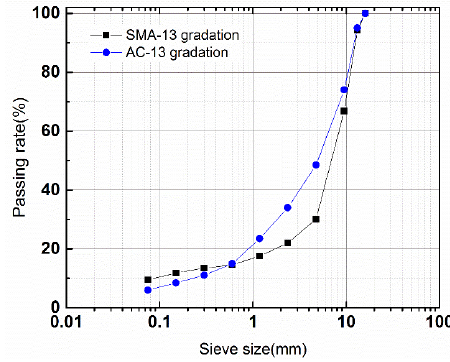
Figure 1. Chart of AC(Asphalt Concrete)-13 and SMA (Stone Mastic Asphalt)-13 gradations .